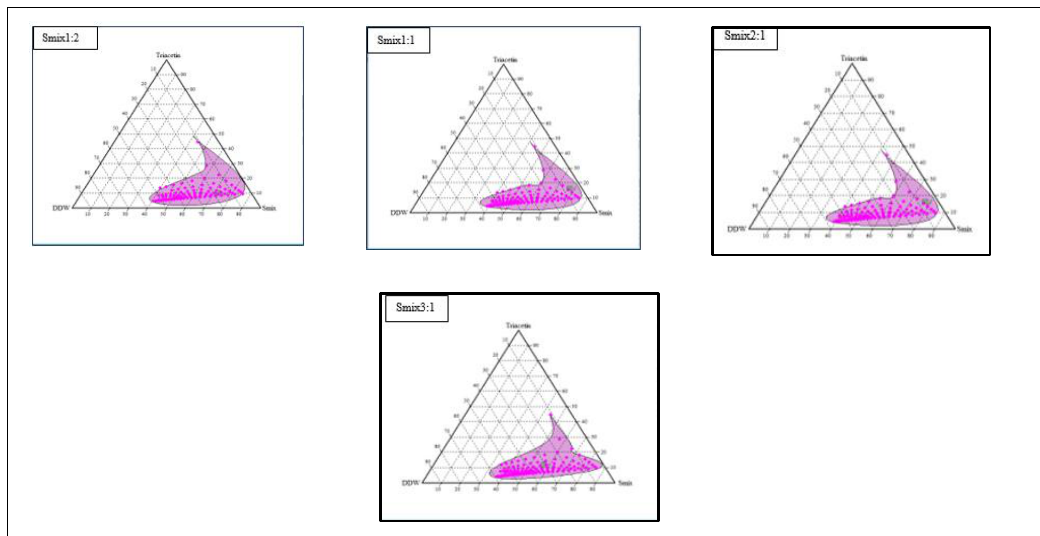
Figure 4. Triangular co-ordinate o/w emulsion diagram using triacetin, tween60: ethanol in different ratios.